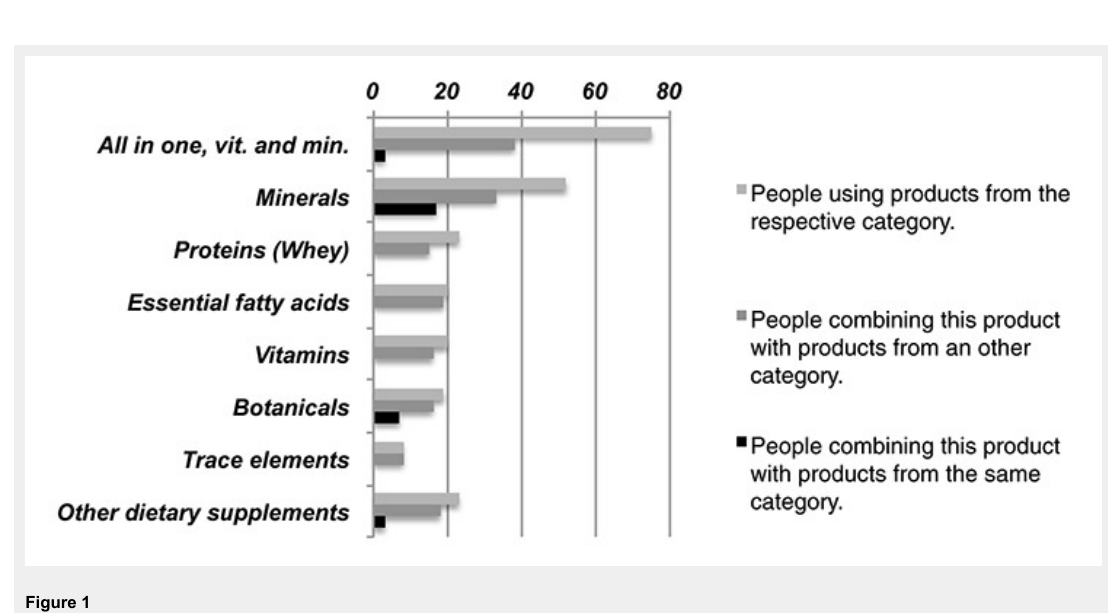
Figure 1 Categories and combinations of dietary supplements used (n =